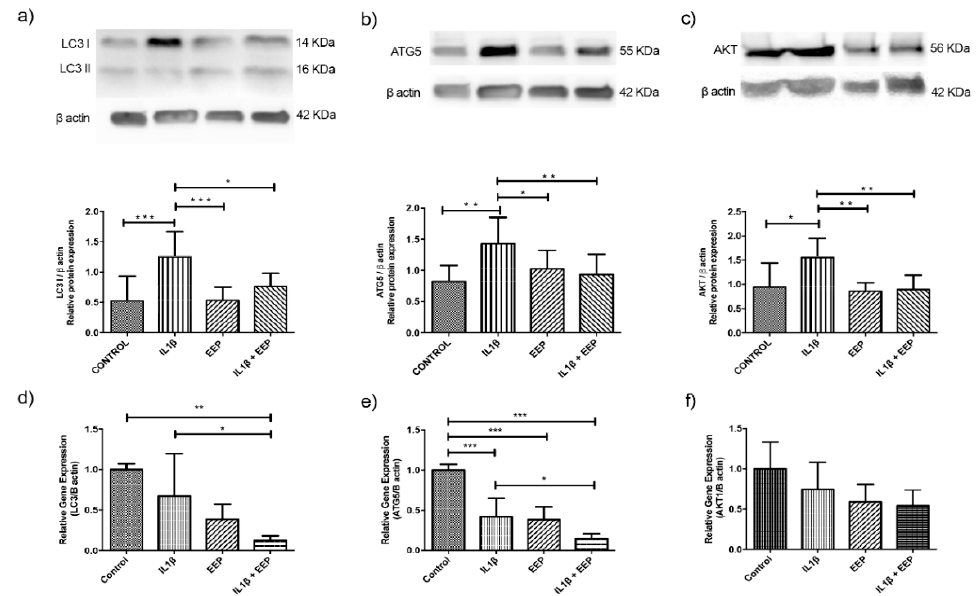
Figure 4. Relative expression of autophagy-related genes and proteins from rabbit chondrocytes stimulated by IL-1 β and treated with EEP for 24 h. ( a – c ) Protein expression of LC3 I, ATG5, and AKT1 evaluated by Western Blotting and quantitative analysis. ( d – f ) Gene expression analysis of markers of the autophagy pathway evaluated by RT-PCR. * p < 0.05, ** p < 0.005, *** p < 0.001. IL-1 β : stimulated with IL-1 β 10 ng / mL, EEP: treated with EEP 2.5 µ g / mL, IL-1 β EEP: treated with IL-1 β and EEP. All data were normalized by control (without treatment). One-way ANOVA, Tukey Multiple Comparison Test. SW normality test. ( N = 5 independent experiment).